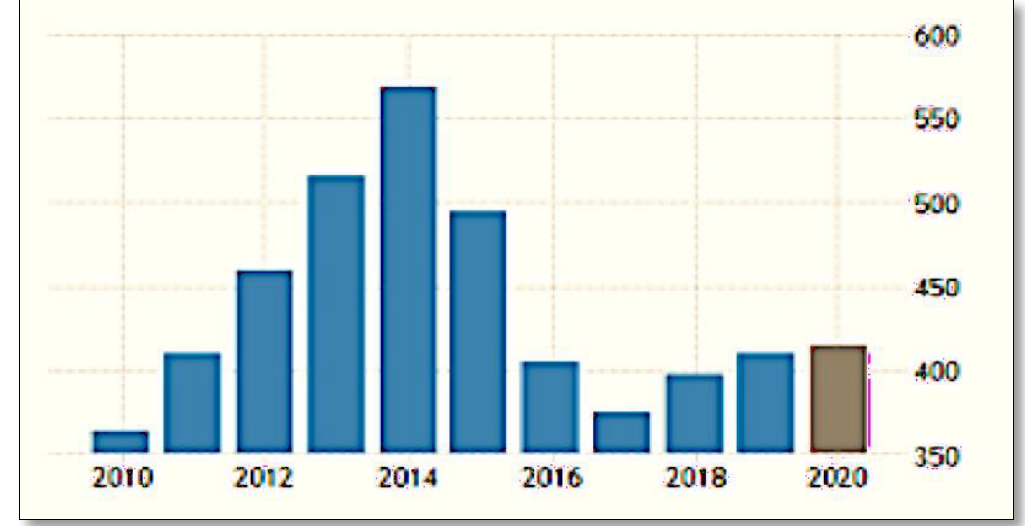
Figure 5. Nigeria's GDP Growth Rate [January 2017 to January 2020]. Source: Trading Economics, 2020.